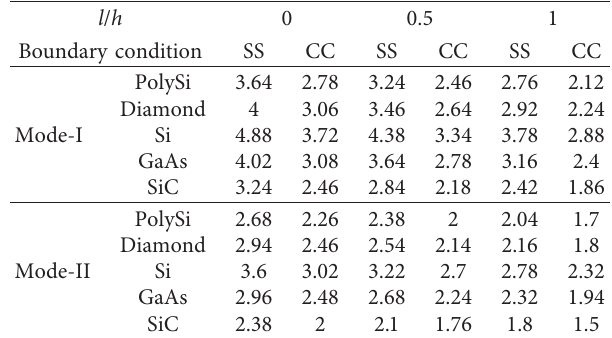
Table 2: Critical thickness ( h ) of a microplate for different c structural materials, dimensionless length scale parameter, vibrating modes, and boundary